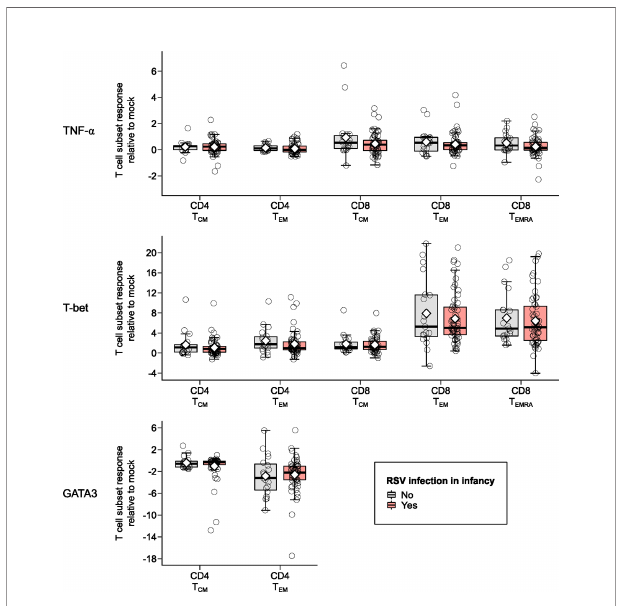
FIGURE 3 | Memory T cell responses at ages 2-3 years after in vitro stimulation with RSV 3-12 according to RSV infection in infancy: TNF- a , T-bet, and GATA3. The x-axis indicates the CD4 (TCM and TEM) and CD8 (TCM, TEM, and TEMRA) memory T cell subsets. The y-axis denotes the T cell subset response relative to mock following in vitro stimulation with RSV. The box-and- whisker plots show the mean (diamond), median (middle bar), 1 st quartile (lower bar), 3 rd quartile (upper bar), minimum observation above the lower fence (lower whisker), maximum observation below the upper fence (upper whisker), and individual observations (circles) for each group. The signi fi cant p-values (<0.05) for the comparison between groups using generalized least squares regression to account for clustered data are also